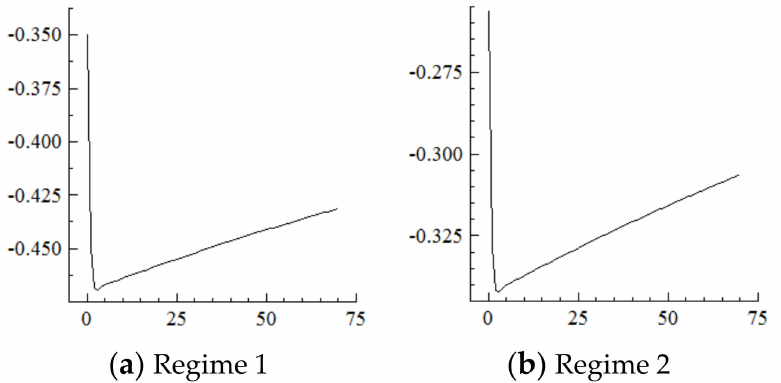
Figure 6. Cumulative Impulse Response of Industrial Structure Upgrading to Capital Stock